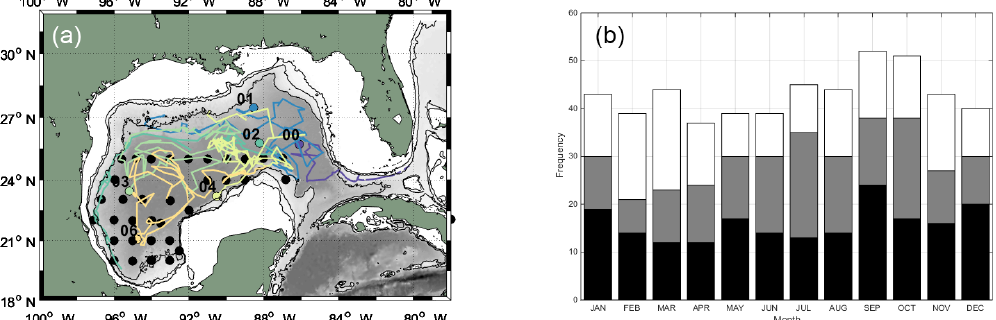
Figure 1. (a) Map of the study area, with tracks of BOEM floats (colored lines), and XIXIMI-2 and XIXIMI-3 sampling stations (black circles). Float positions at deployment are indicated by colored circles and numbers. (b) Temporal distribution of the profiles acquired by the BOEM (in black, cyclonic group profiles; in gray, anticyclonic group profiles; in white, remaining